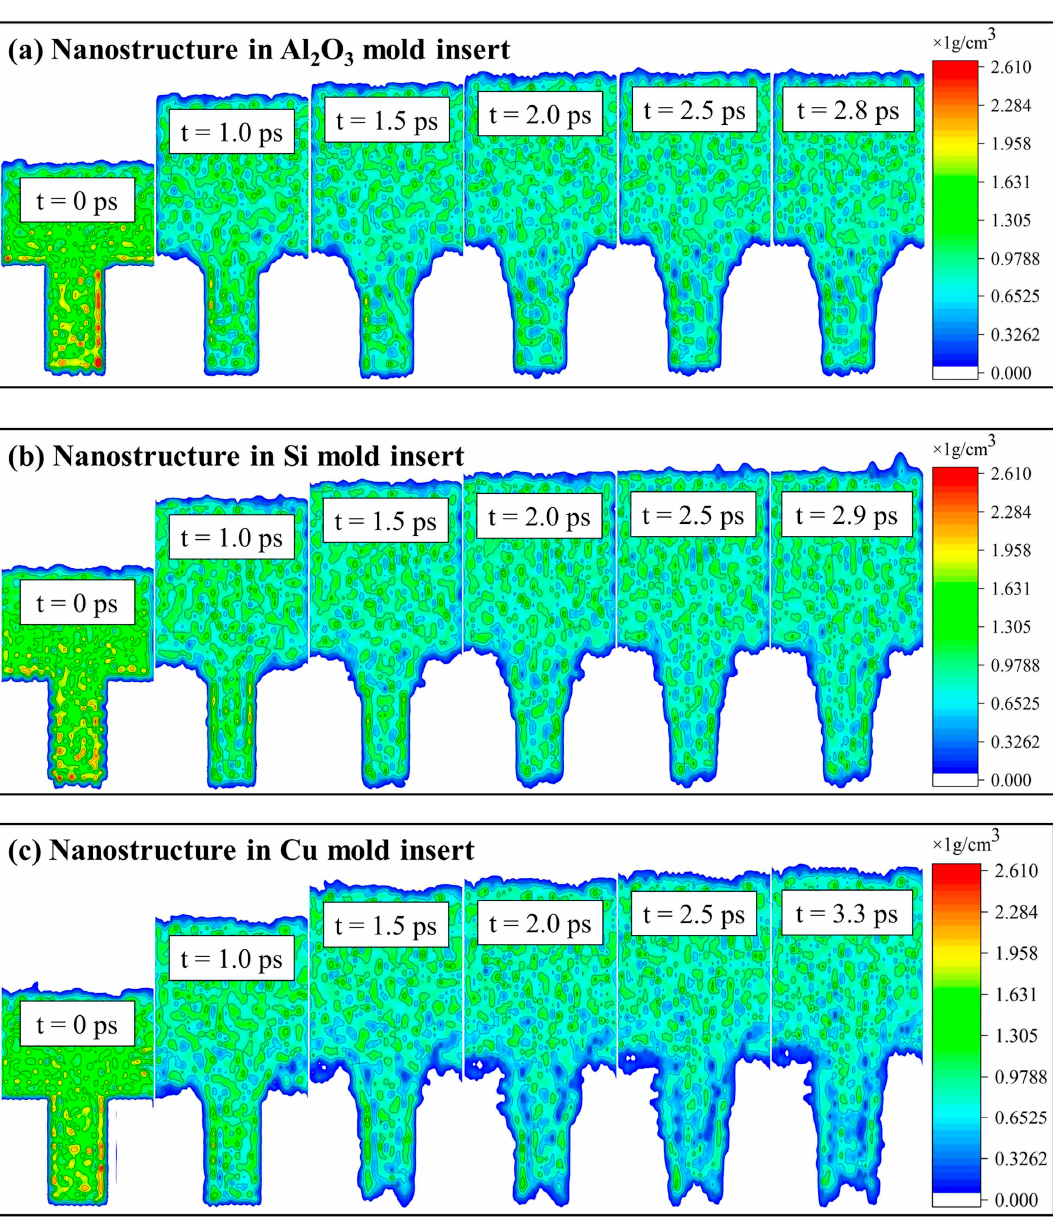
Figure 10. Density distributions of the demolding process of nanostructures in different mold insert materials: ( a ) Nanostructure in Al 2 O 3 mold insert, ( b ) nanostructure in Si mold insert, ( c ) nanostructure in Cu mold insert.